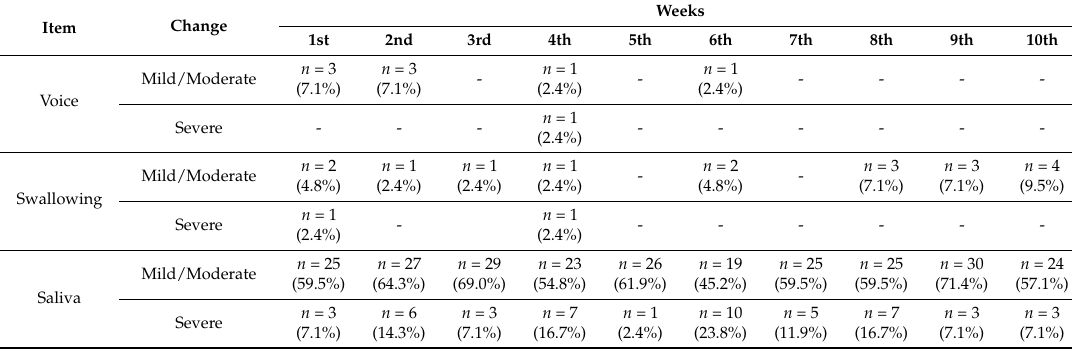
Table 3. Alteration/discomfort of oral function according to the Oral Assessment Guide scores during the 10 weeks of